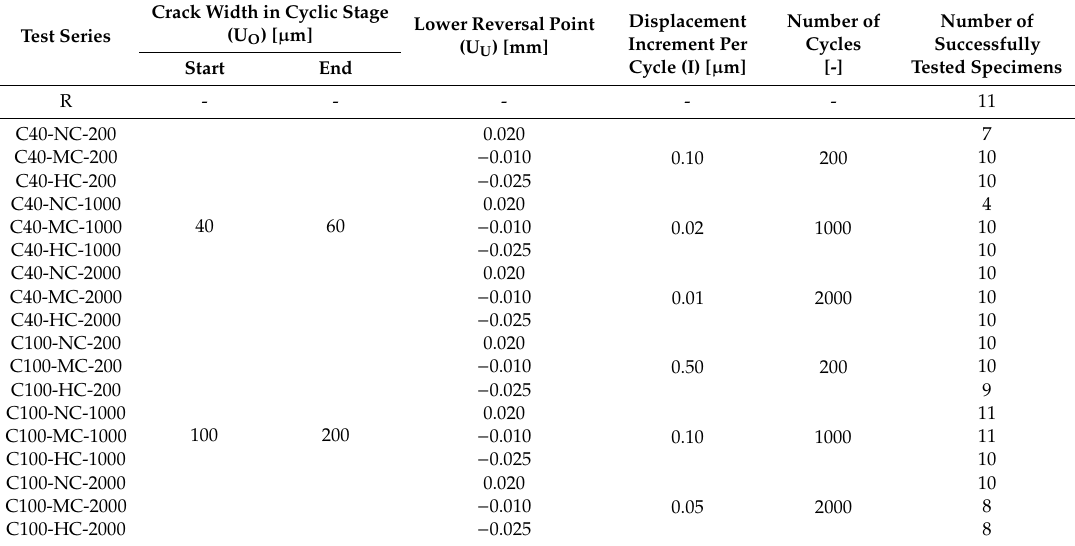
Table 3. Loading parameters for the testing series under